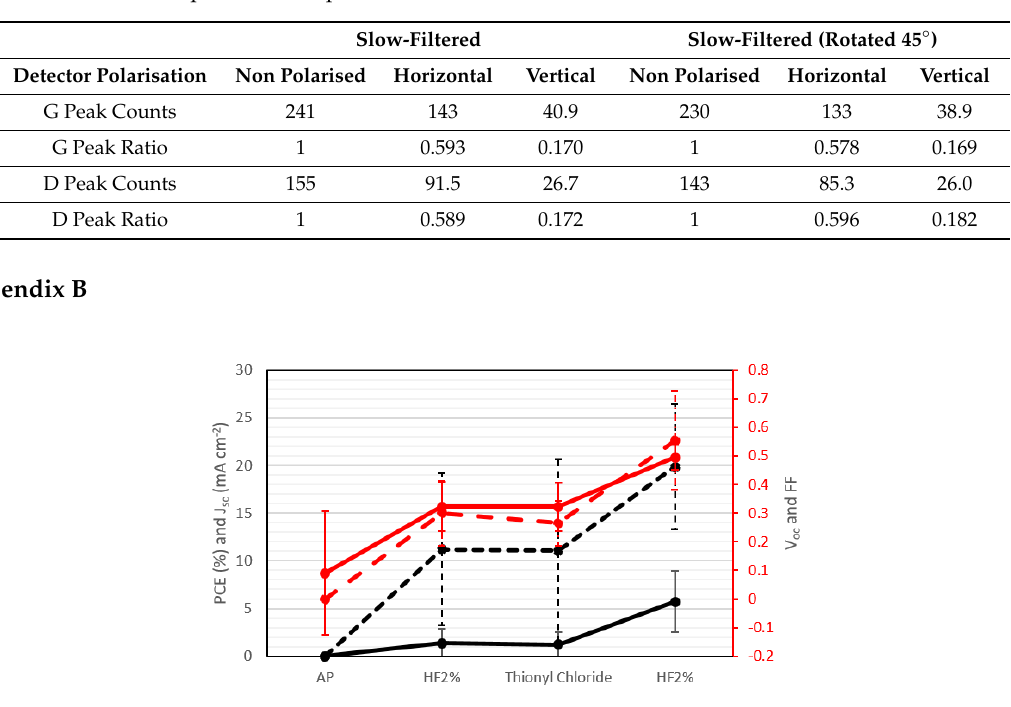
Table A1. G and D peak intensities for each polarisation method for each film. The ratios were calculated with respect to the unpolarised detection measurement.